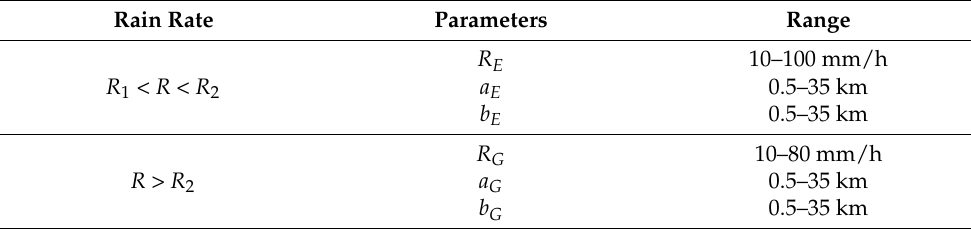
Table 2. The range of parameters of the HYCELL